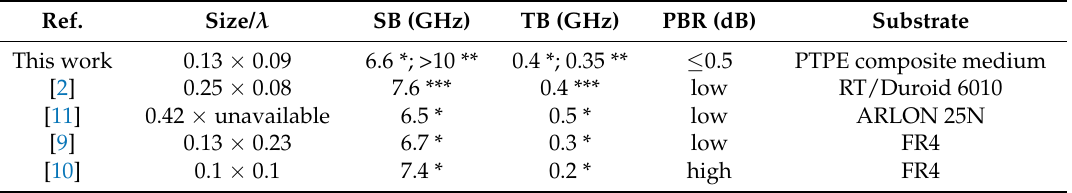
Table 2. Performance comparisons between the reported filters and the proposed filter in this paper (SB: stop-band, TB: transition band, PBR: pass-band ripple, ASB: attenuation in stop-band). Ref. Size/ λ SB